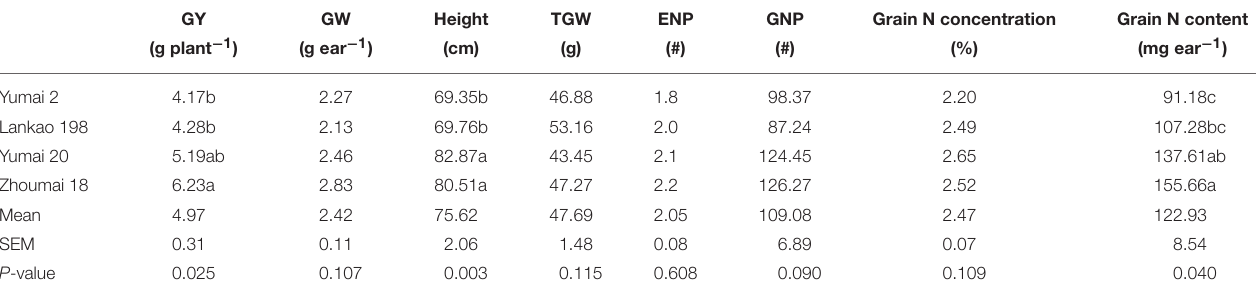
TABLE 1 | The mean, standard error of the mean (SEM) and the P -value for the ONE-WAY ANOVA test for grain yield per plant (GY) and grain weight per ear (GW), plant height, thousand grain weight (TGW), Ear number per plant (ENP), grain number per plant (GNP), grain nitrogen concentration and content for four Chinese winter wheat genotypes.